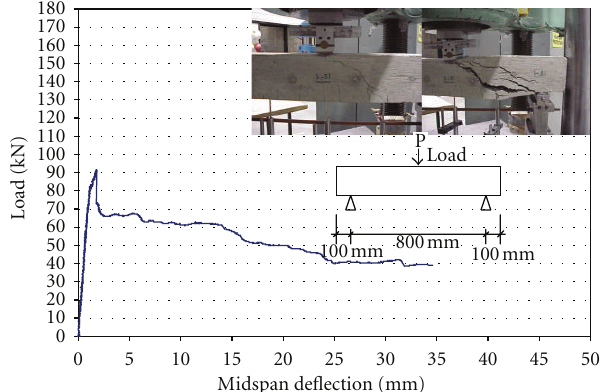
Figure 6: Load versus midspan deflection of control RC beam